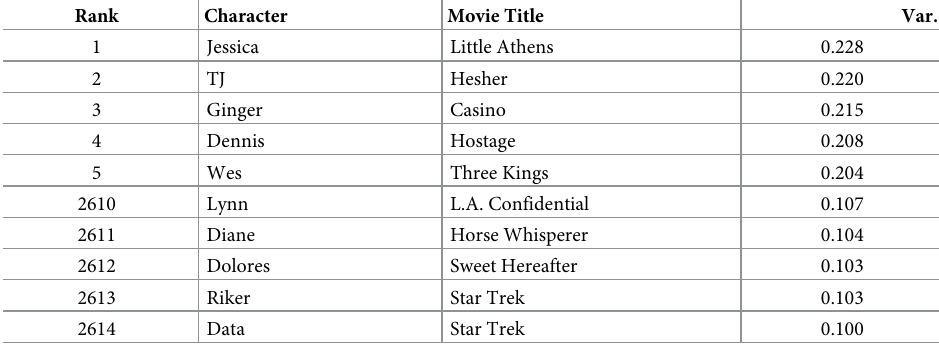
Table 3. Characters with the highest/lowest emotional variability (var.) in the v–a space. Note that the bottom rank number is less than the total number of characters in the data because some characters had insufficient number of dis- placements to obtain reliable averages.